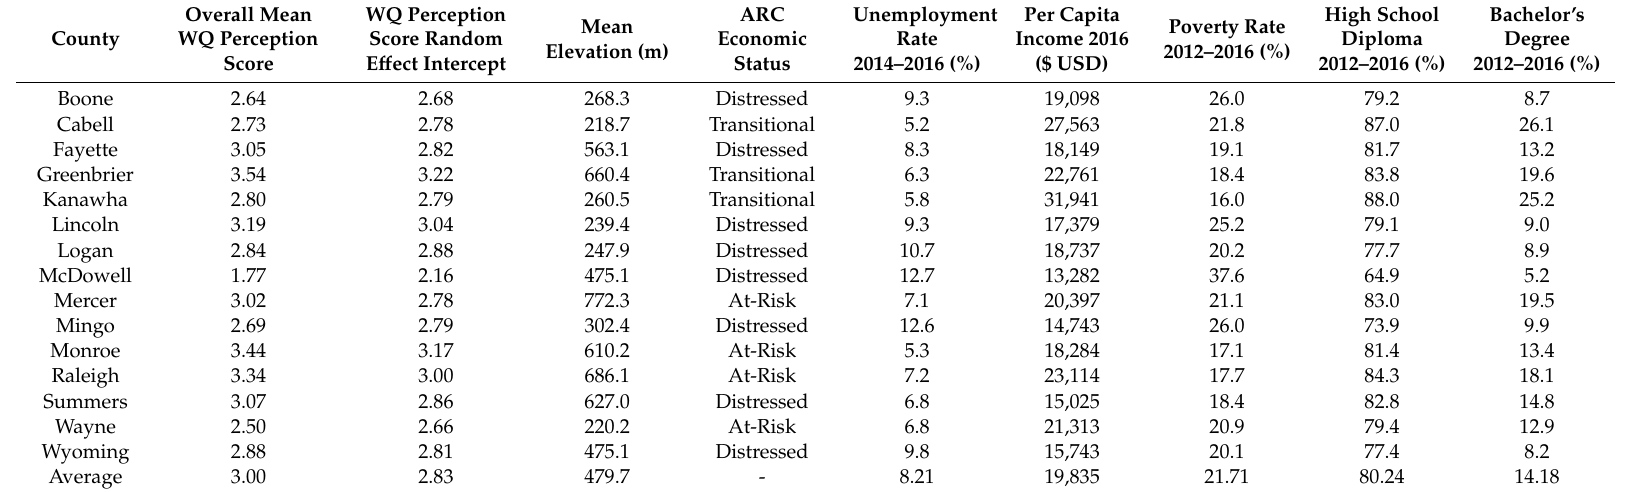
Table 1. Study area elevation and socioeconomic statistics summarized by county. The random intercept for each county-level water quality perception score is also provided for reference to the mixed-model